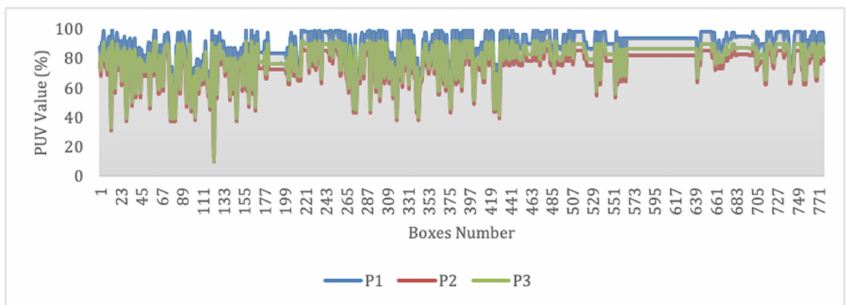
Figure 13. A comparison of PUV values according to pallet sizes for the 1 K instances for which the algorithm can be